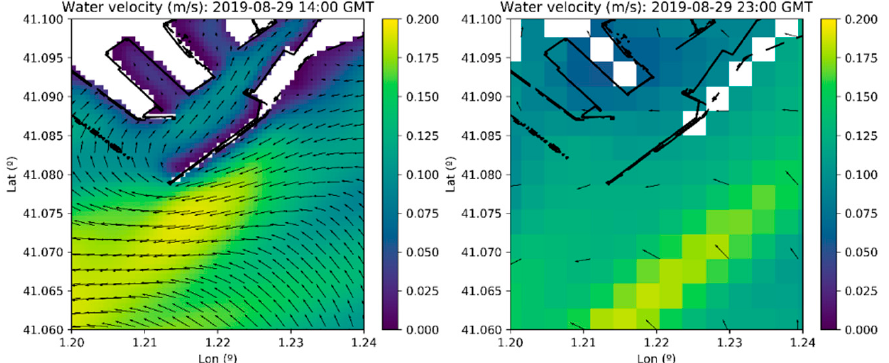
Figure 6. Surface water velocity obtained from SAMOA products ( left : Port model, right : Coastal model).